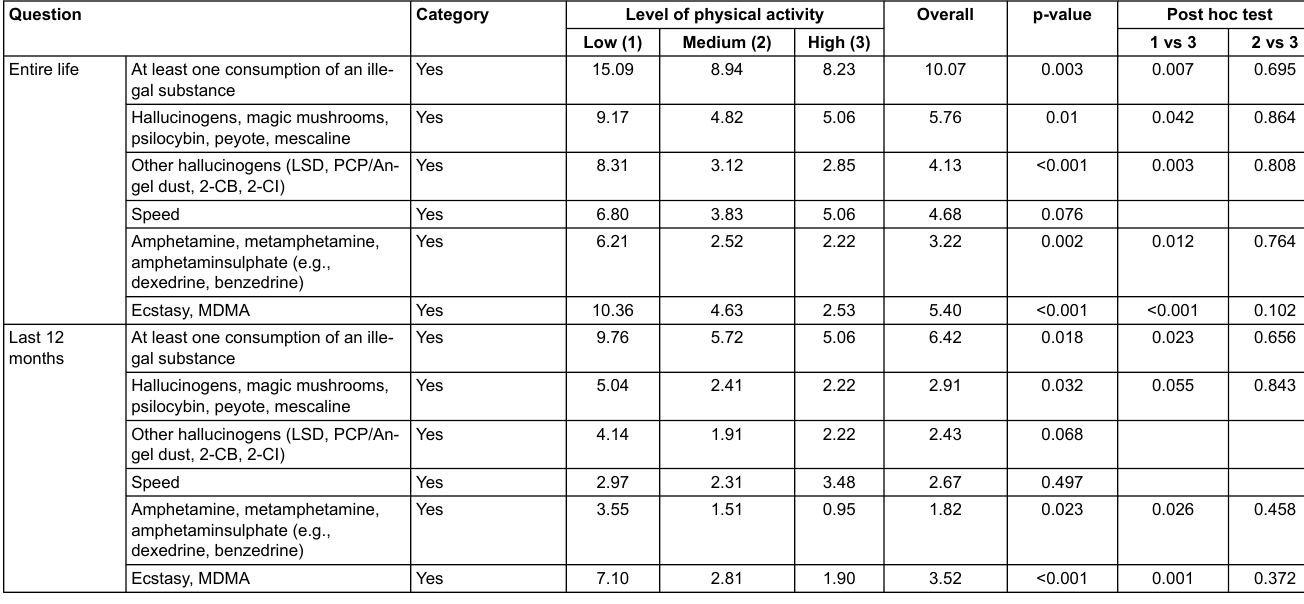
Table 7: Consumption of other illicit substances by level of physical